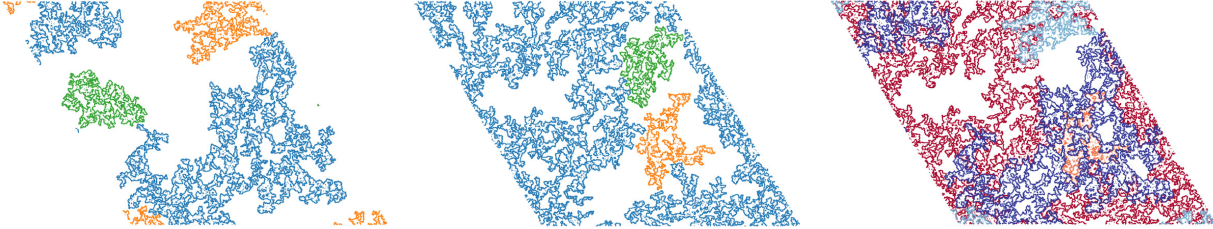
FIG. 2. The left (middle) panel shows the boundary of the largest three R A -type ( R B -type) regions of the Dulmage-Mendelsohn decomposition of a honeycomb lattice sample with L ¼ 4000 and periodic boundary conditions, with vacancy density n right panel shows the largest two R A -type and R B -type regions of the same sample. The color-coding of the boundaries has been changed in the right panel (relative to the other two panels) for greater visibility. See Secs. I – III for further details.